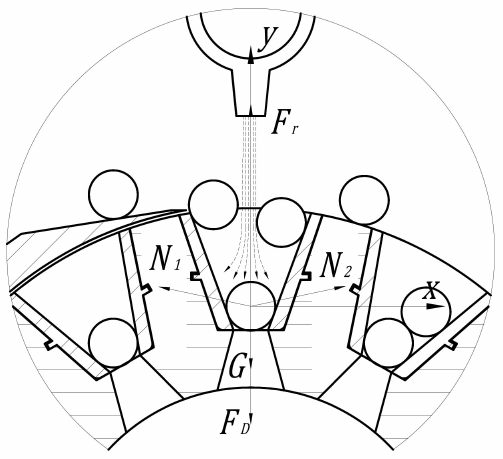
Figure 4. The force map of the seed pressed to the bottom of the